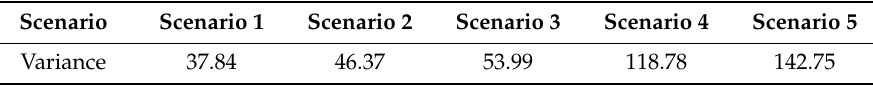
Table 3. Variance of the microgrid load curve in di ff erent